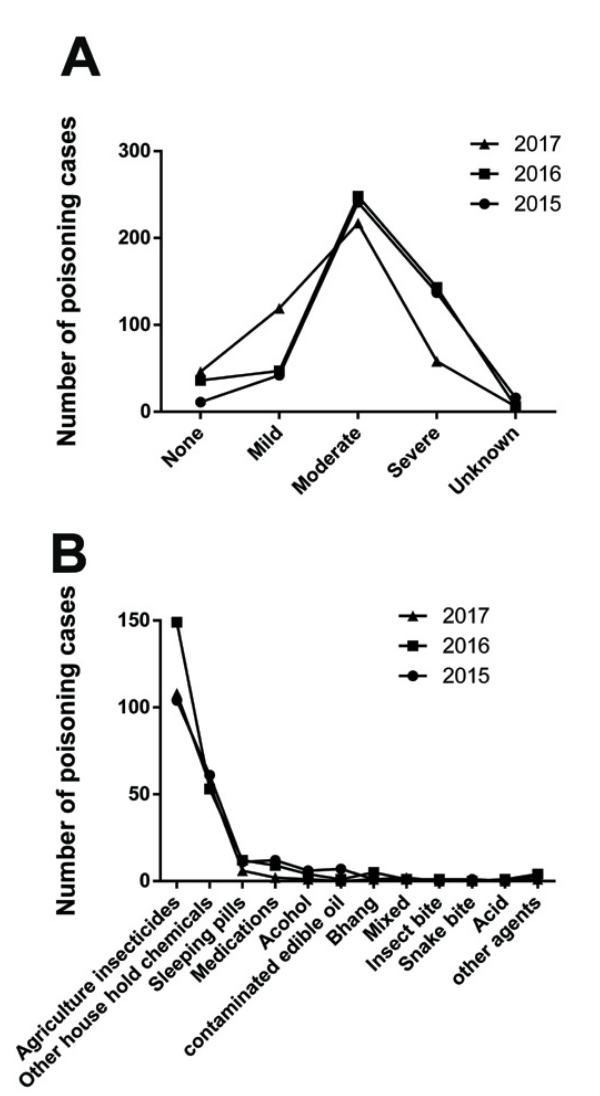
Figure 2. The annual trend of poisoning cases in relation to the severity of cases at the time of admission to hospital (A) and the agents involved in poisoning (B) between 2015 and